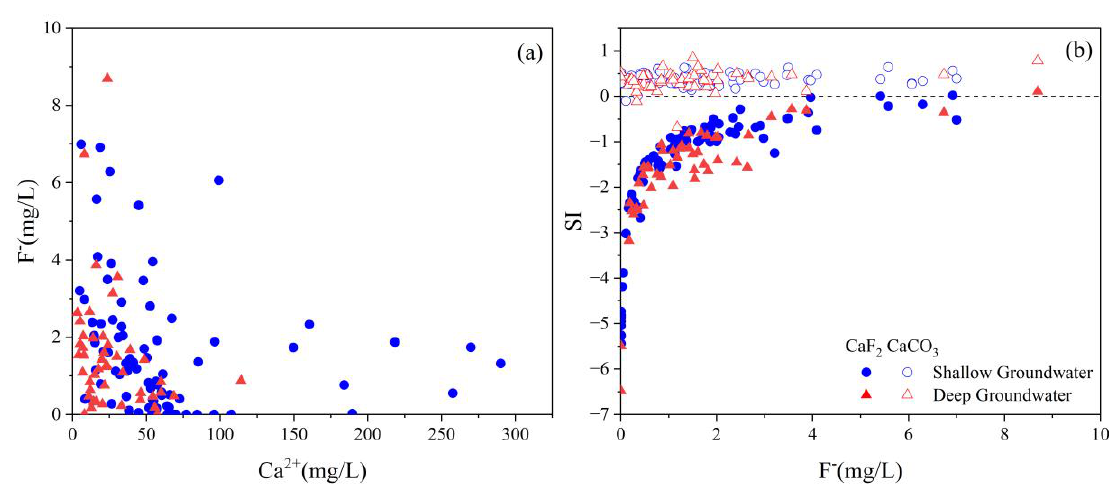
Figure 9. ( a ) Scatter plots of Ca 2+ vs. F − ; ( b ) SI of calcite and fluorite in